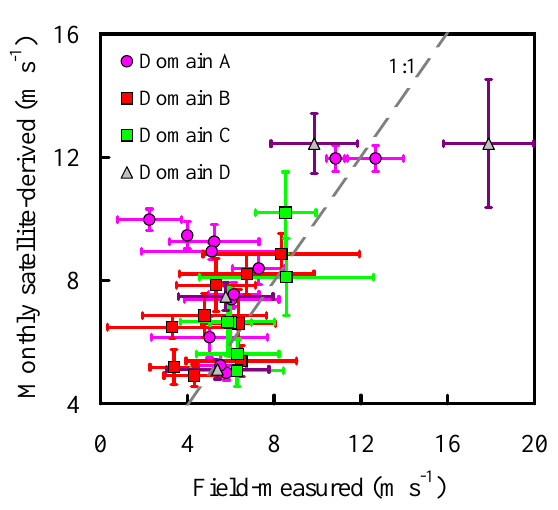
Fig. 4. Comparison between monthly satellite-derived sea surface wind speeds (QuikSCAT, level 3) and field-measured wind speeds at 10m height. Data are shown as mean ± standard deviation. The 1:1 relationship is shown as grey dashed line.